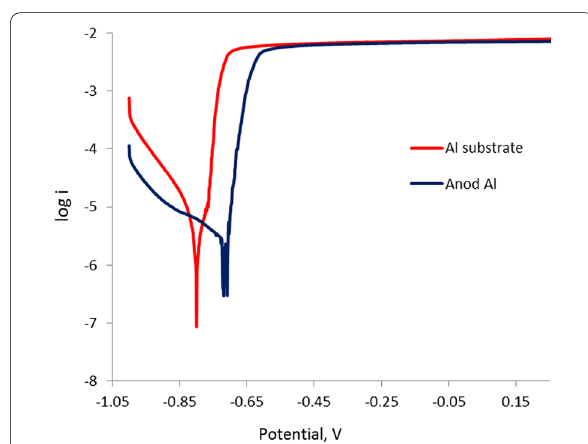
Fig. 9 lSV of aluminum substrate and anodized aluminum samples in 3.5% NaCl solution